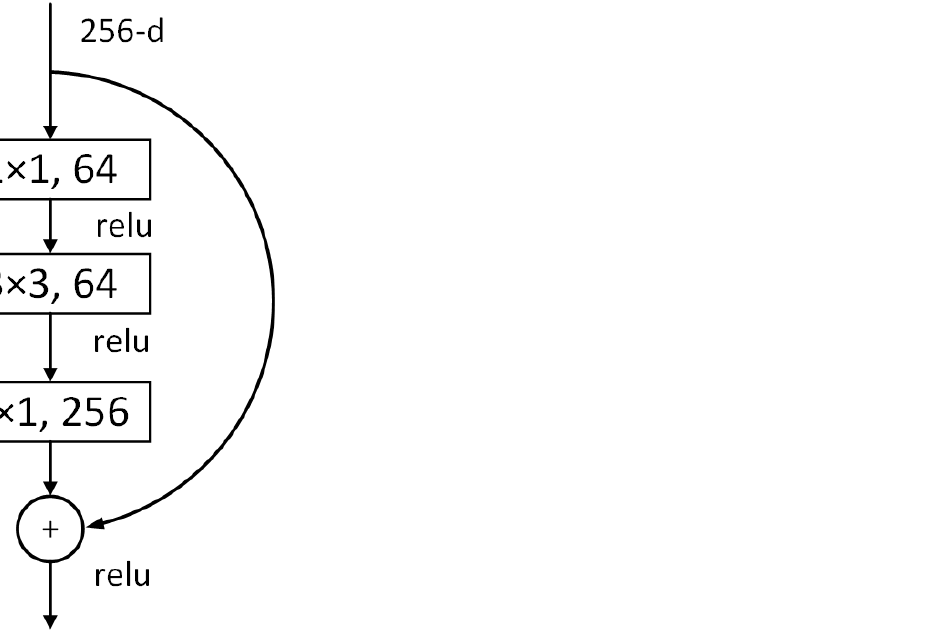
Figure 5. Building block of Residual Network depicting ReLu activation function and various convolution layers